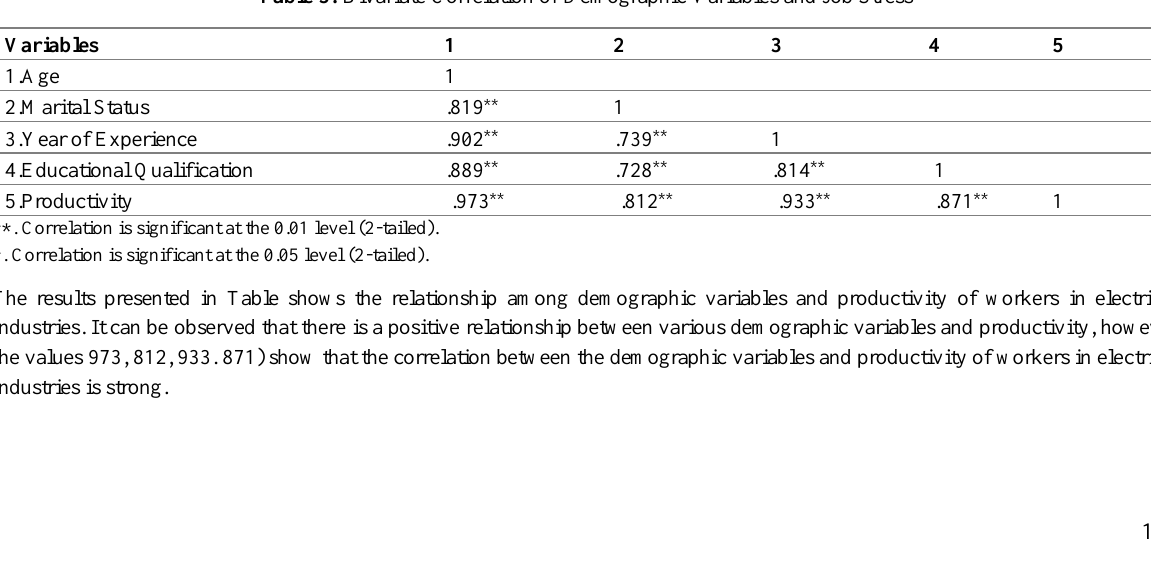
Table 3: Bivariate Correlation of Demographic Variables and Job